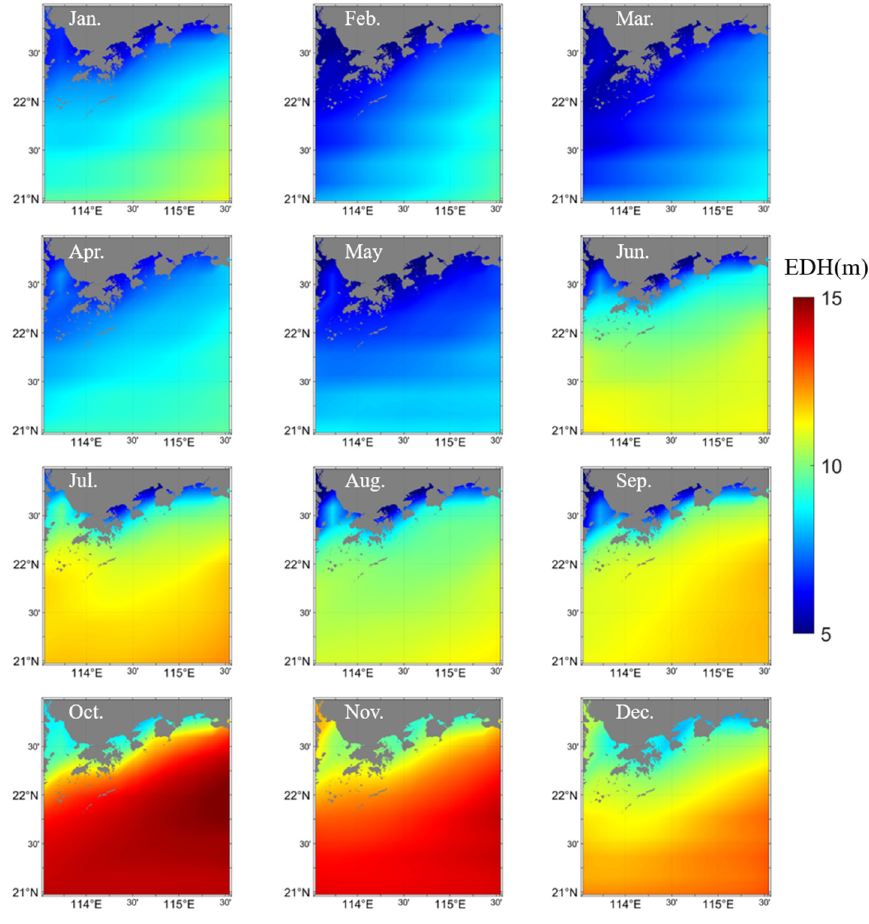
Figure 7. Spatiotemporal characteristics of the EDH in the study area.